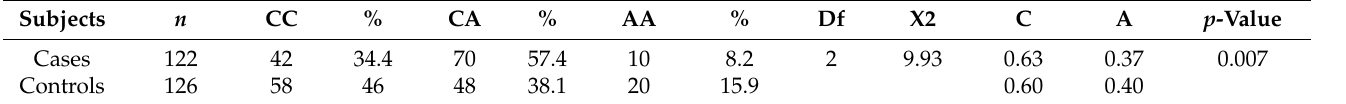
Table 2. The distribution of VEGF rs699947 C/A genotypes in T2D cases and controls.